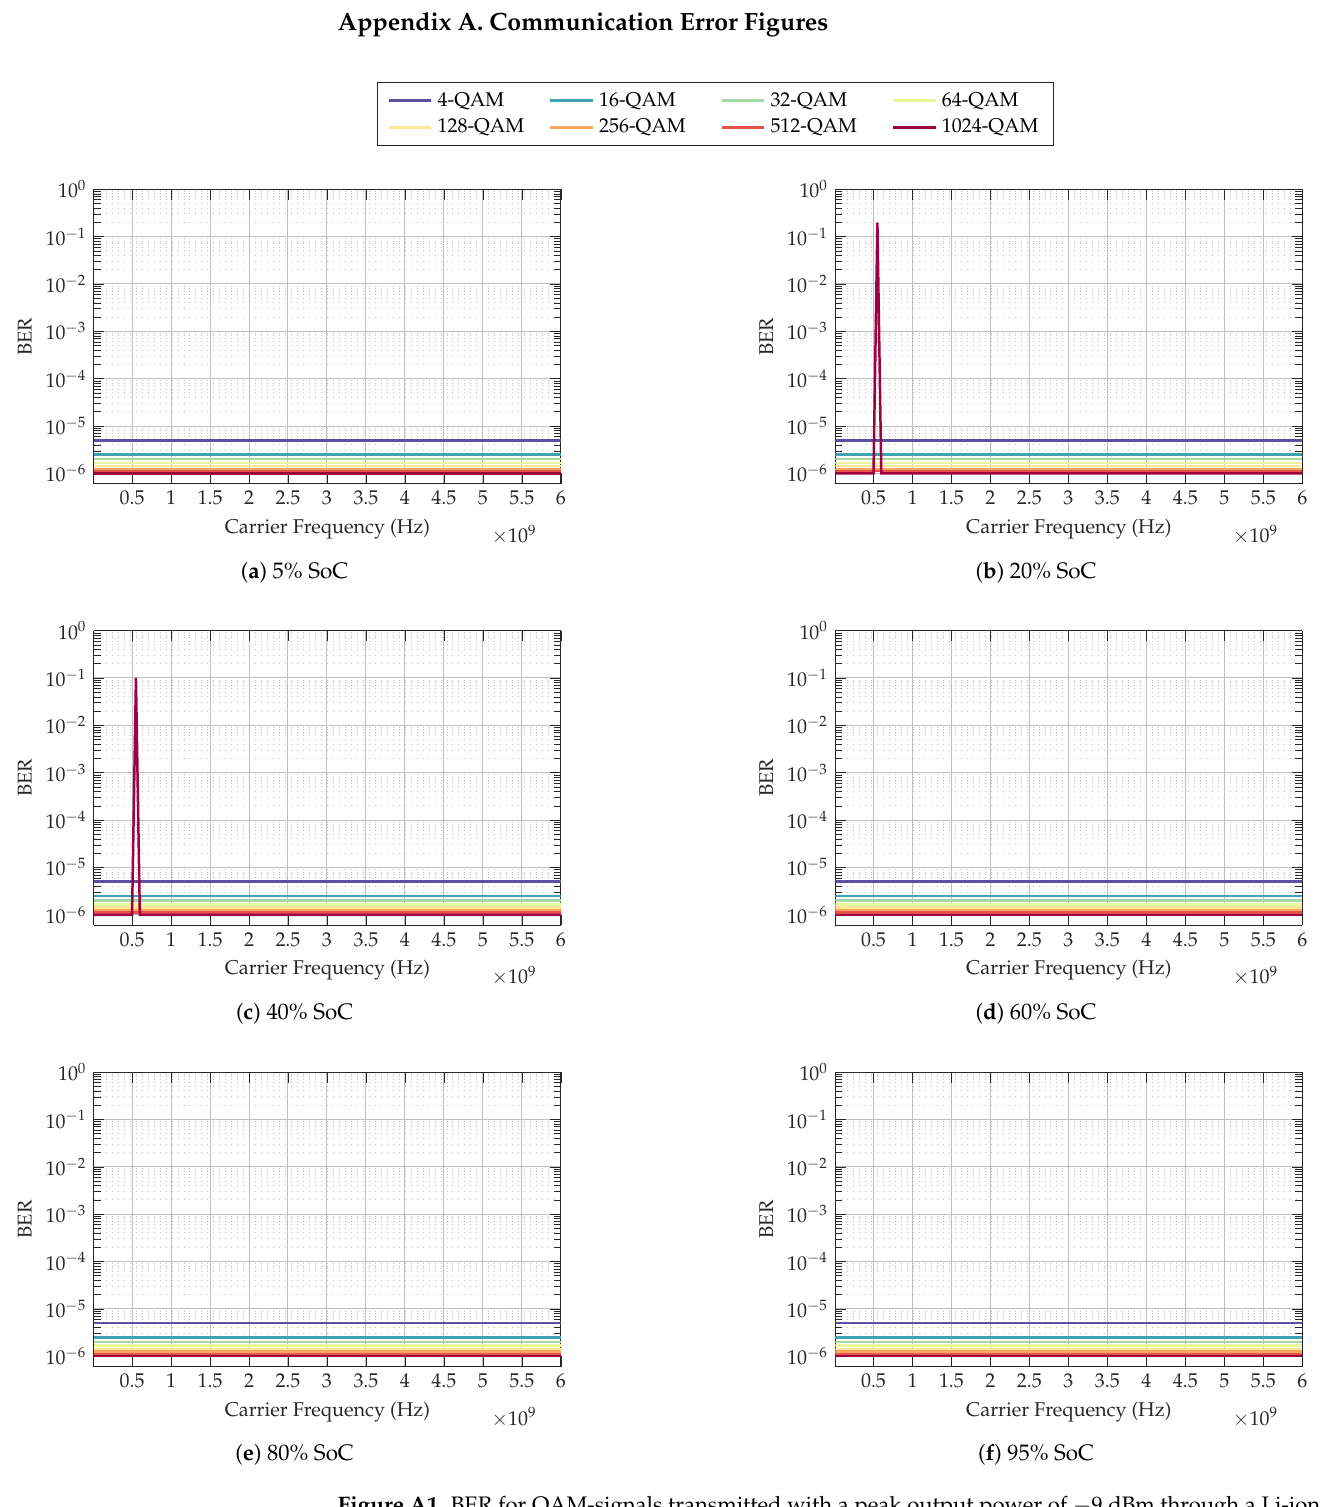
9 dBm through a Li-ion −